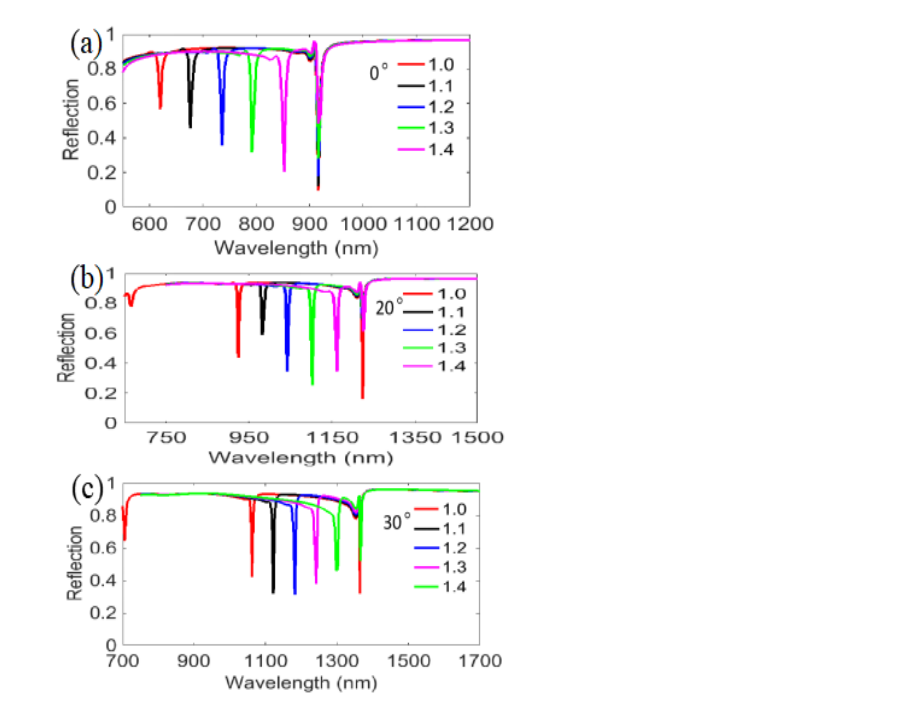
Figure 5. Reflection spectra for TM polarized illumination on the bottom with different RIs at discussed incident angles of ( a ) 0°, ( b ) 20° and ( c ) 30°.